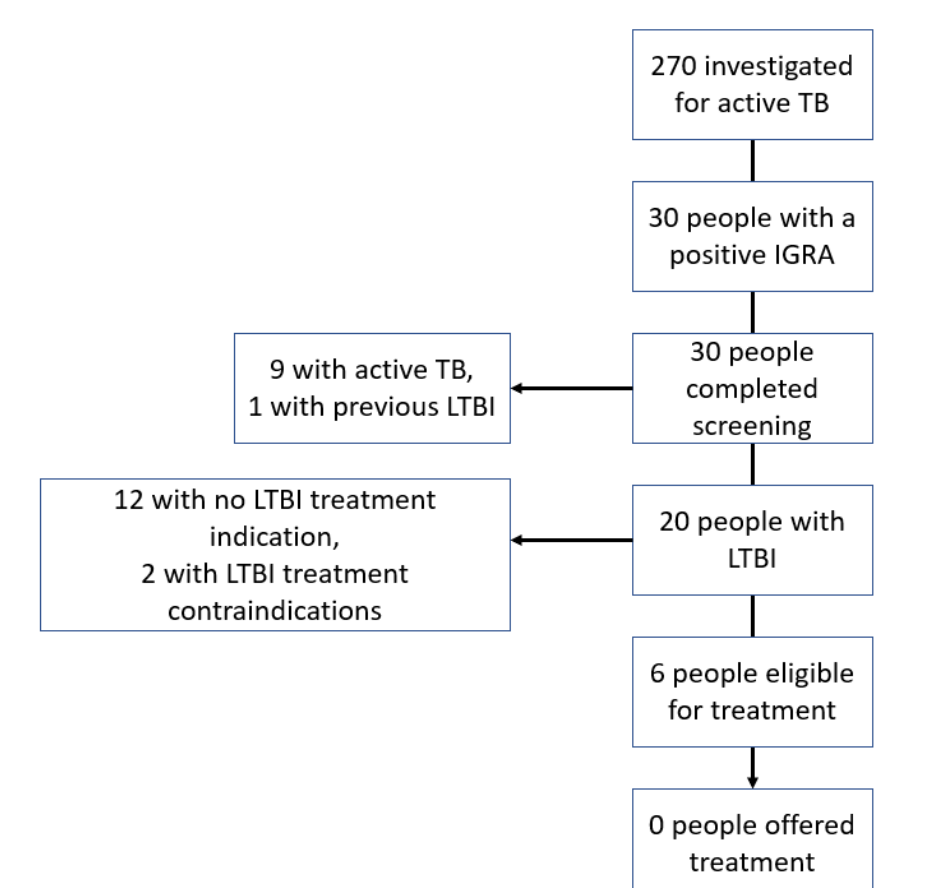
Figure 3. Cascade of interferon-gamma release assay testing performed during investigation for active tuberculosis.